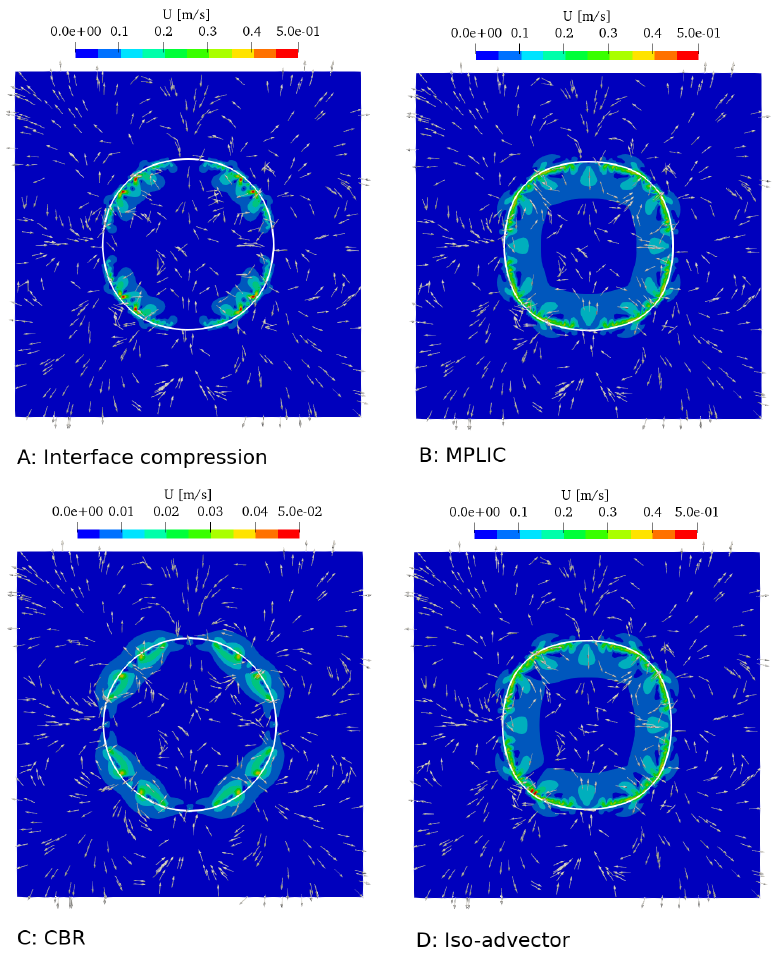
Figure 2. The spurious current contour around gas bubble interface in stagnant liquid in zero gravity | g | = 0 m/s 2 at t = 1 ms for various VoF reconstruction methods. Please note the one order of magnitude difference in the color